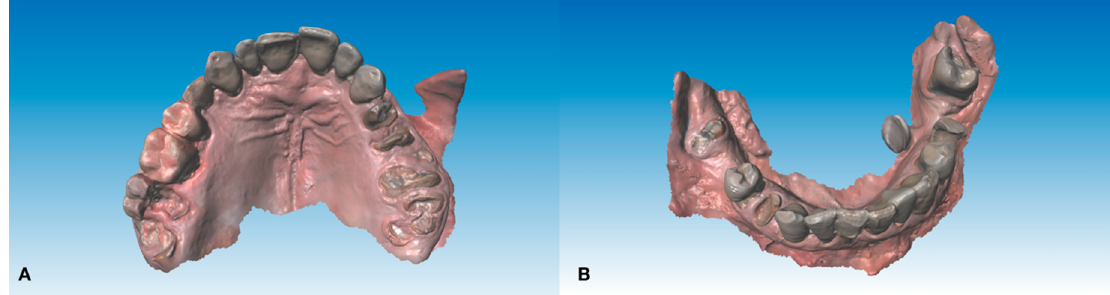
Figure 3. Preliminary digital impression. ( A ) Maxillary preliminary digital impression. ( B ) Mandibular preliminary digital impression.